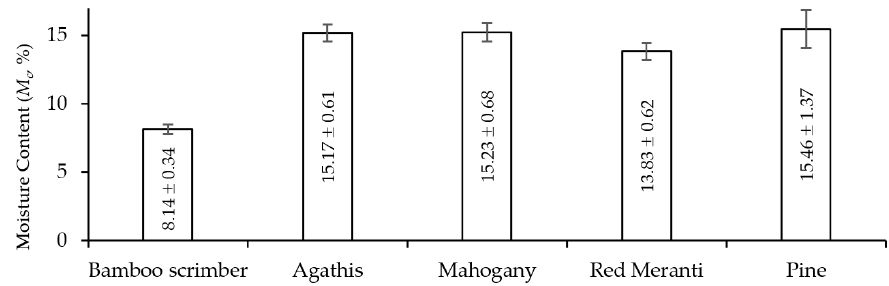
Figure 3. Air-dried moisture content of all specimens.